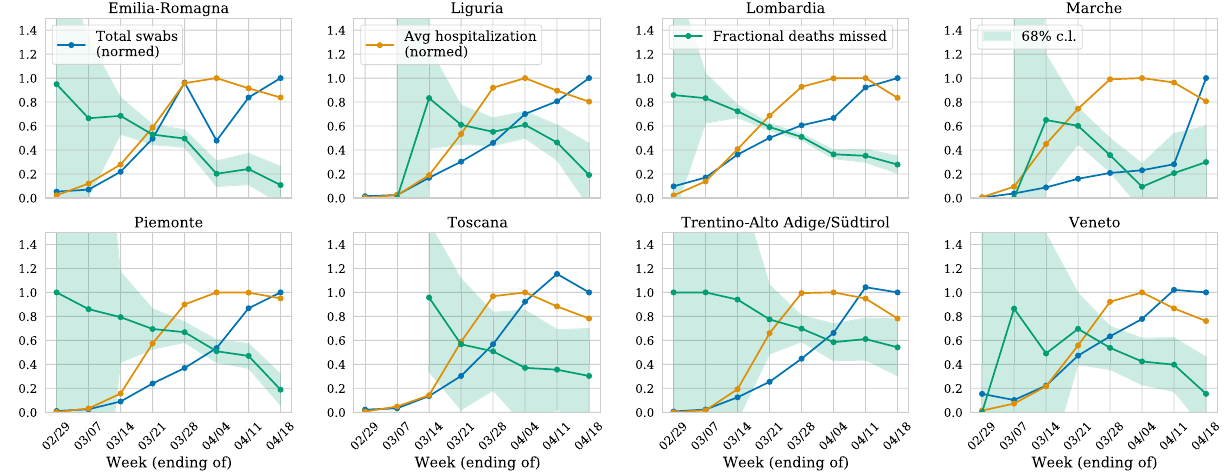
Fig. 4 Fraction of missed deaths over time. For the period of the pandemic, we show per week the fraction of missed deaths (green) with corresponding 1 − σ (68% CI) estimated from the variance of the Gaussian model, the number of hospitalizations (normalized with the maximum weekly hospitalization up to 18 April 2020, in orange) and the number of tests conducted (normalized as a fraction of tests conducted in the week of 11 – 18 April 2020, in blue). We fi nd that the missed fraction goes down as the number of tests increases while the hospitalizations have remained consistently high in the last 4